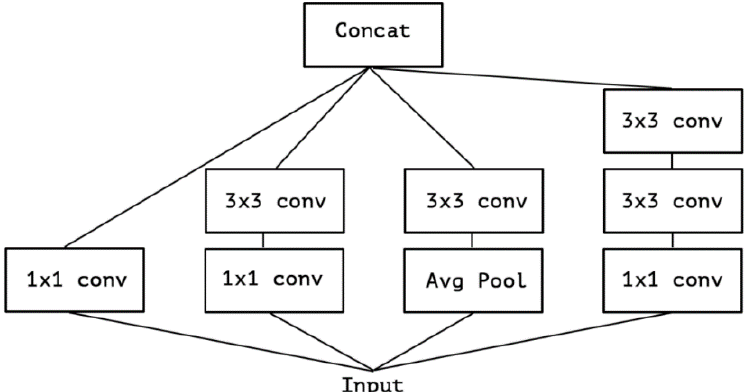
Figure 9. A typical Xception module (Reprinted from ref. [12]).